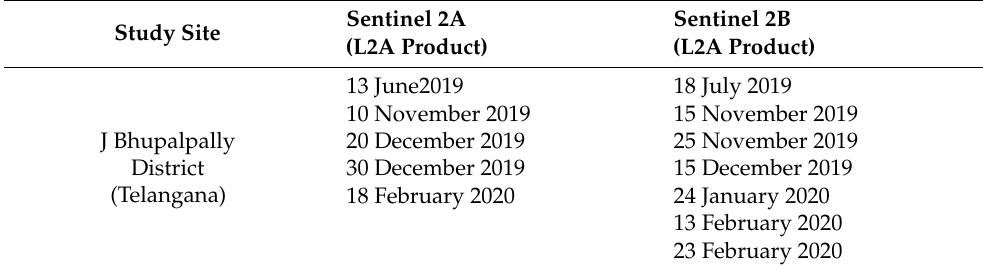
Table 1. List of Sentinel 2 Temporal datasets used in the study. Study Site